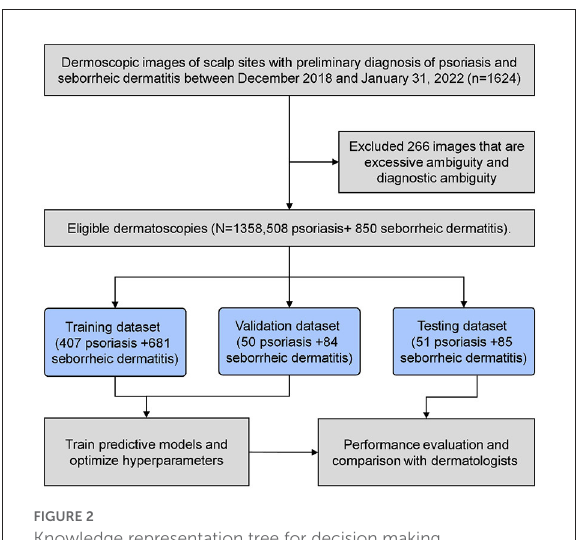
FIGURE2 Knowledge representation tree for decision